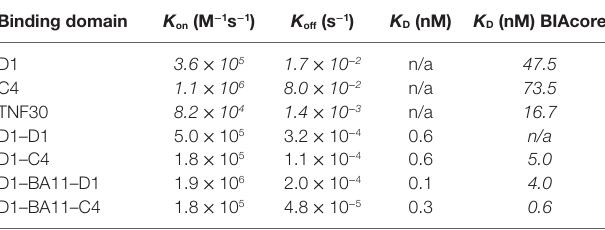
TaBle 1 | Binding kinetics of anti-hTNF- α variable new antigen receptor using Octet ® RED96 system. Binding